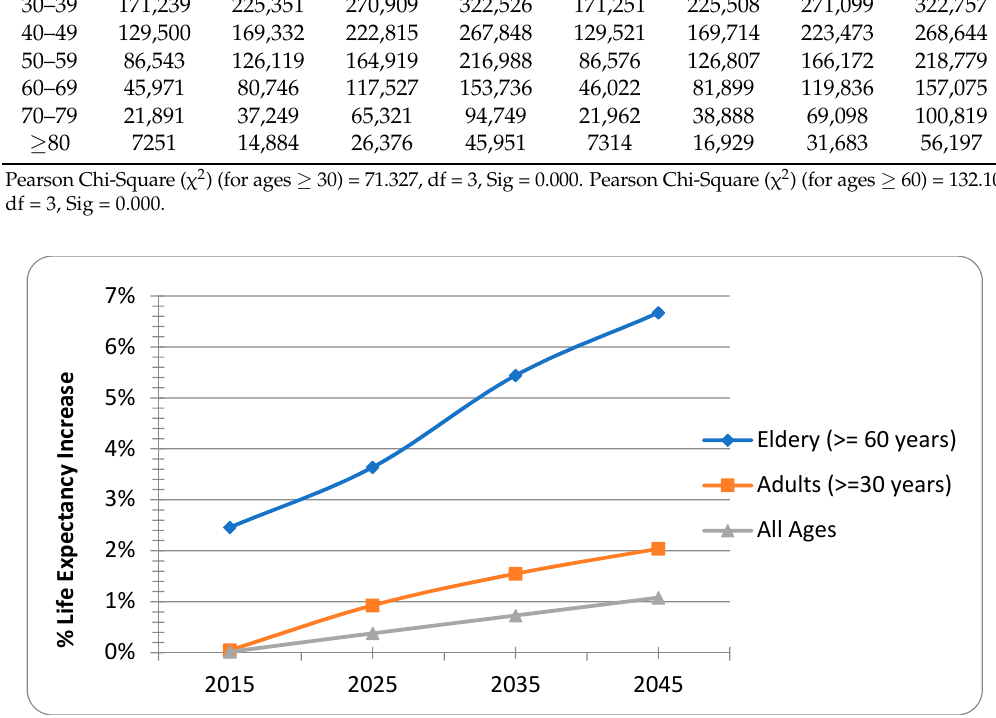
Figure 4. Sensitivity analysis for % of life expectancy for the years 2015, 2025, 2035, 2045.